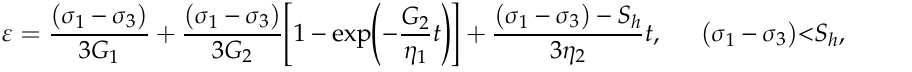
Table 2. Parameter values of classical Nishihara model.